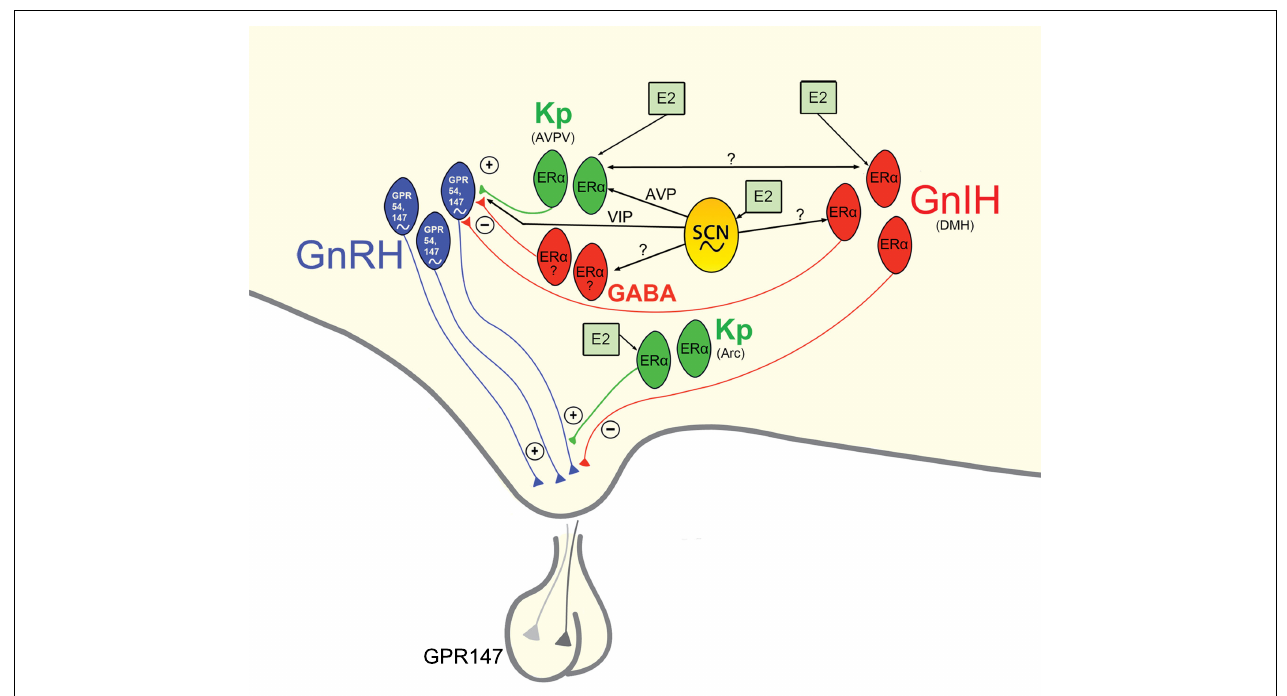
specifically to GnRH neurons, the emergence and sexual dimorphism of kisspeptin cells and fibers that project to GnRH cell bodies provide compelling evidence for the direct connection between these two neural phenotypes. Connections between the GnIH and GnRH systems indicate a putative role for GnIH in modulating the negative feedback effects of estrogen with SCN communication allowing for removal of negative feedback on the reproductive axis during the time of the LH surge. A similar role for SCN-GABA interactions is likely, although projections SCN projections and ER α expression specific to AVPV GABAergic cells have not been empirically examined. Kisspeptin cells in the ARC likely serve to modify GnRH output at the level of the terminal. See text for additional